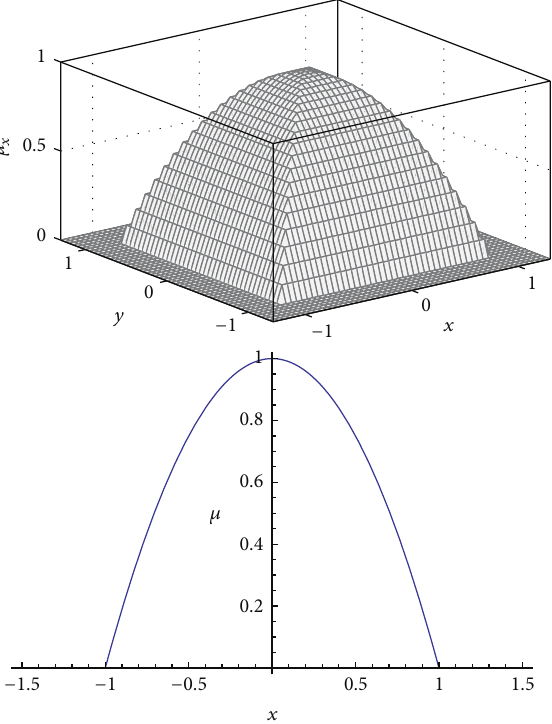
Figure 1: Membership function of z and a